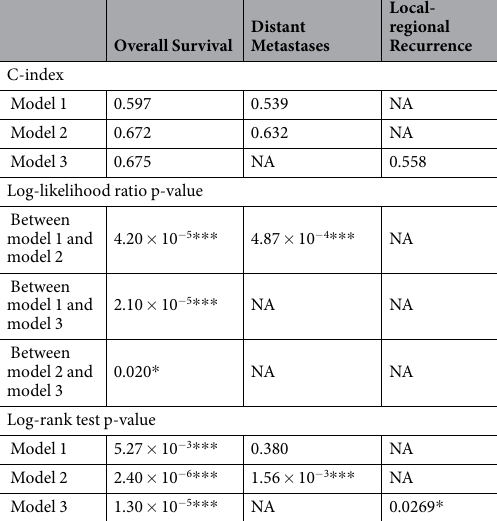
Table 2. Final comparison of the three models for each outcome. For the c-indices and log-rank test p-values, a value of NA indicates that no extra covariates were selected for this model and thus the value cannot be evaluated. Similarly, a value of NA for the log-likelihood ratio p-value implies that the two models being compared had the same covariates and thus the log-likelihood ratio cannot be computed. Model 1 is the model with only clinical factors. Model 2 is the model with clinical factors and pretreatment features. Model 3 is the model with clinical factors, pretreatment features, and delta-radiomics features. * Significant at p < 0.05; ** Significant at p < 0.005; *** Significant at p <